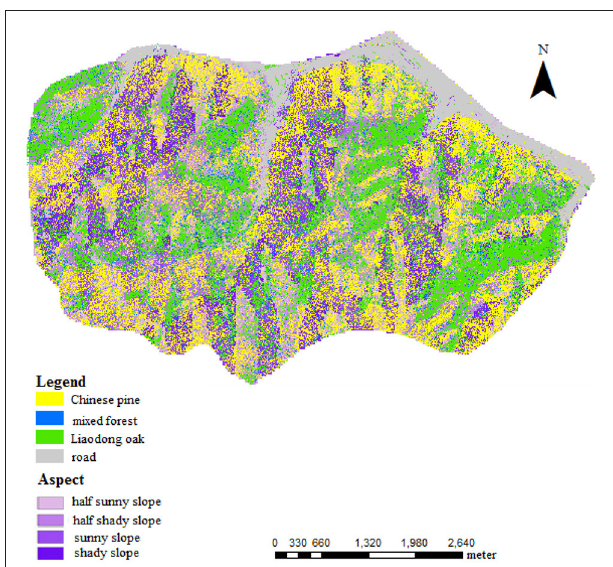
FIGURE 8 | Aspect-stand overlay